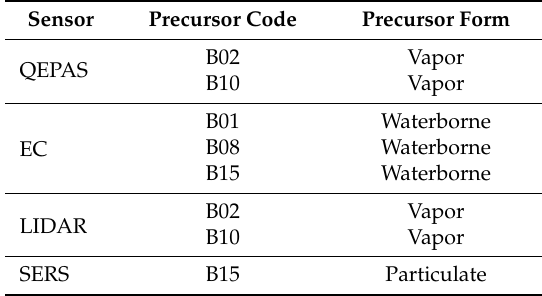
Table 3. Precursors considered as targets of the different sensors included in the